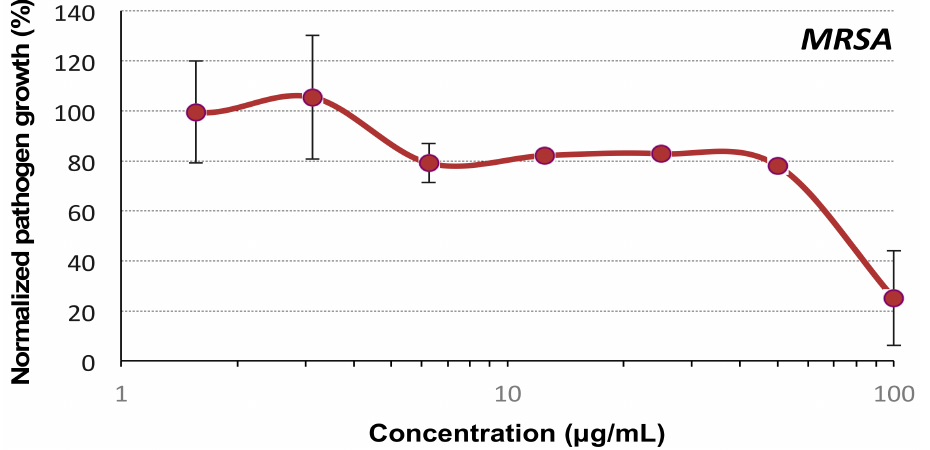
Figure 3. Antibacterial activity of the dimeric urea-based foldamer DIM-3 on MRSA . The foldamer was incubated for 24 h at 37 ◦ C in 100 µ L of Mueller–Hinton broth (MHB) medium with the bacterial strain. The control is composed of the bacterial suspension mixed with PBS (=corresponds to 100% growth). Each value corresponds to the mean value of 3